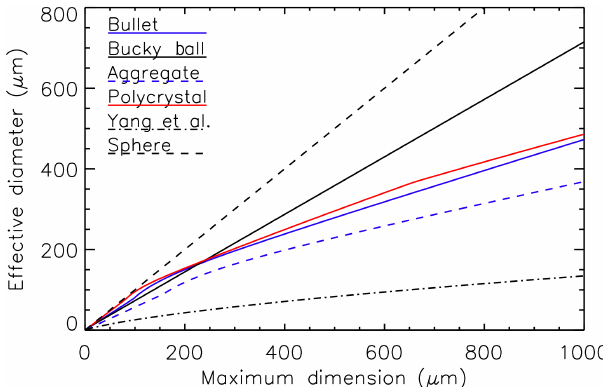
Figure 23. Ice single-crystal effective diameter as a function of maximum dimension for the bullet, Bucky ball, aggregate, and poly- crystal models, Yang et al. (2013) bullet rosettes, and spheres (see